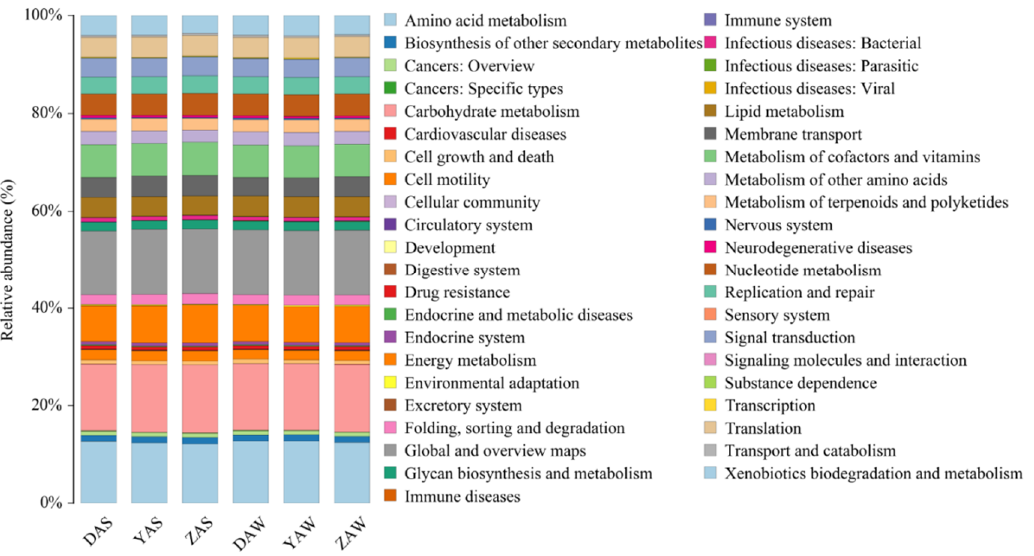
Figure 4. Relative abundances of genes attributable for different bacterial functions according to KEGG level 2 functional categories.